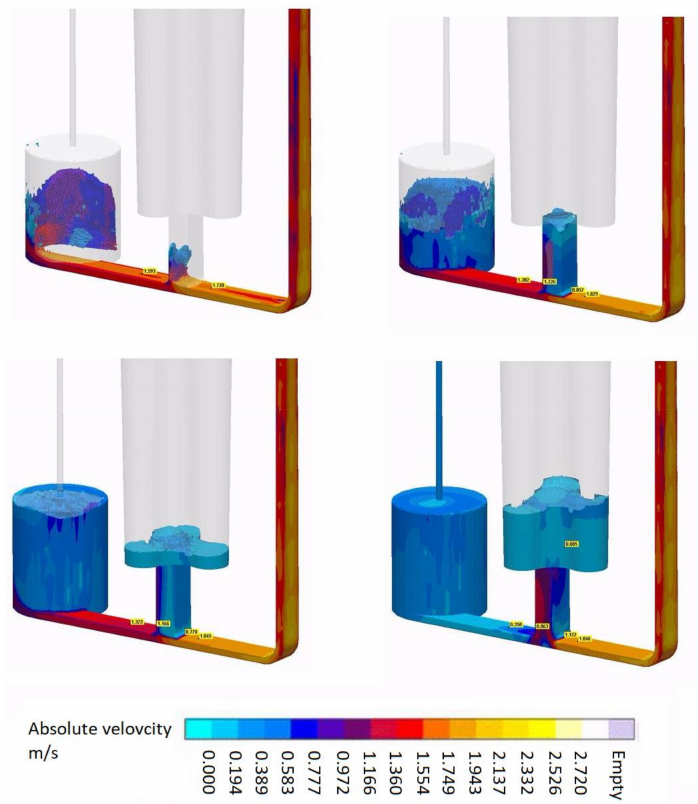
Figure 9. Spin trap gating system; filling time 10